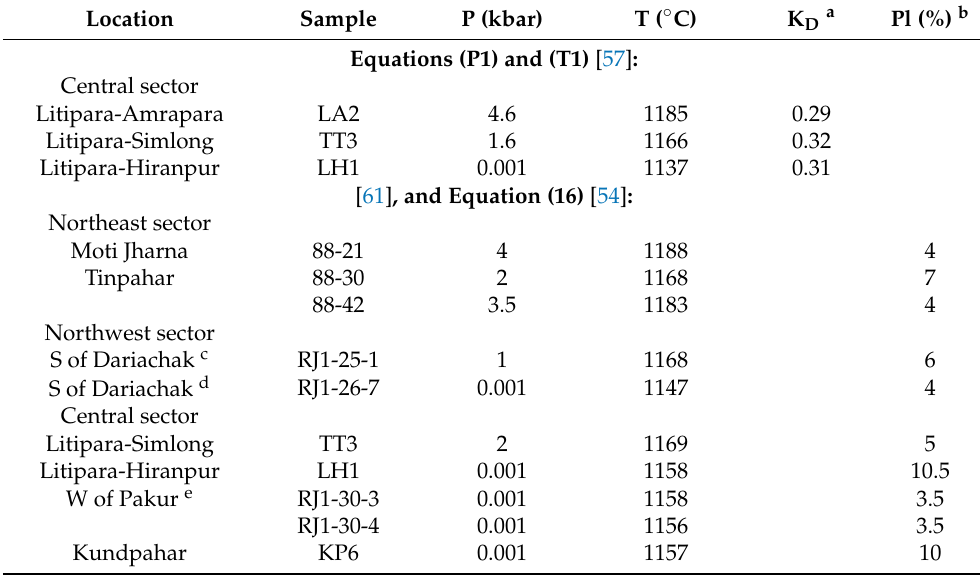
Table 4. Clinopyroxene-bulk and whole rock thermobarometry of the Rajmahal